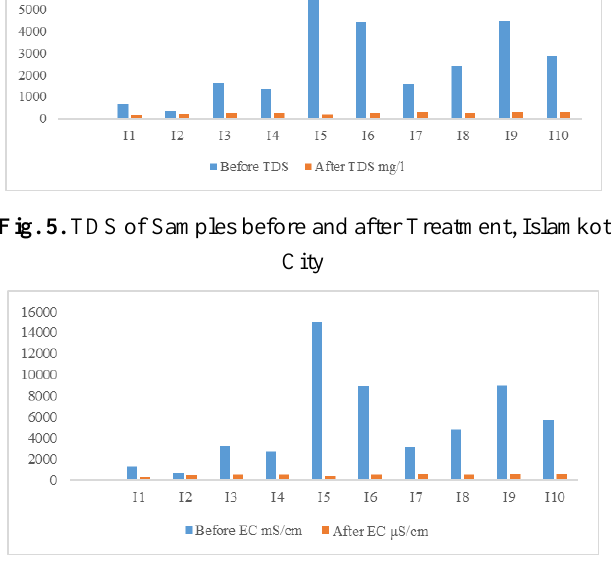
Fig. 6. EC of Samples before and after Treatment, Islamkot